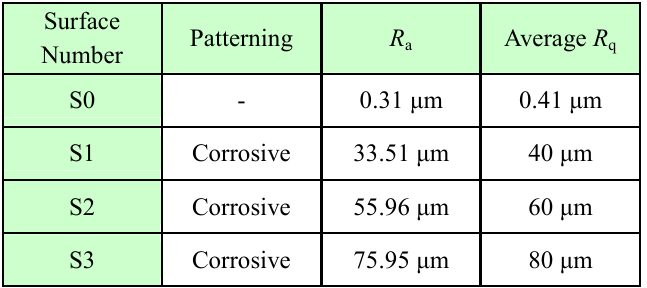
Table 1. Average root-mean-square roughness, R